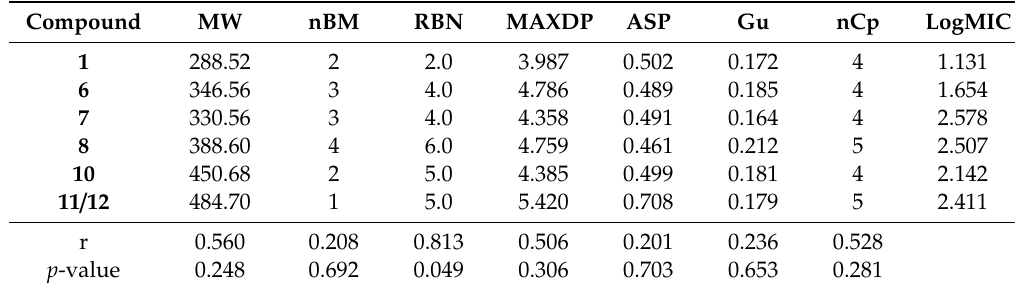
Table 2. Correlation analysis between selected molecular descriptors and the MIC values against Staphylococcus aureus (ATCC